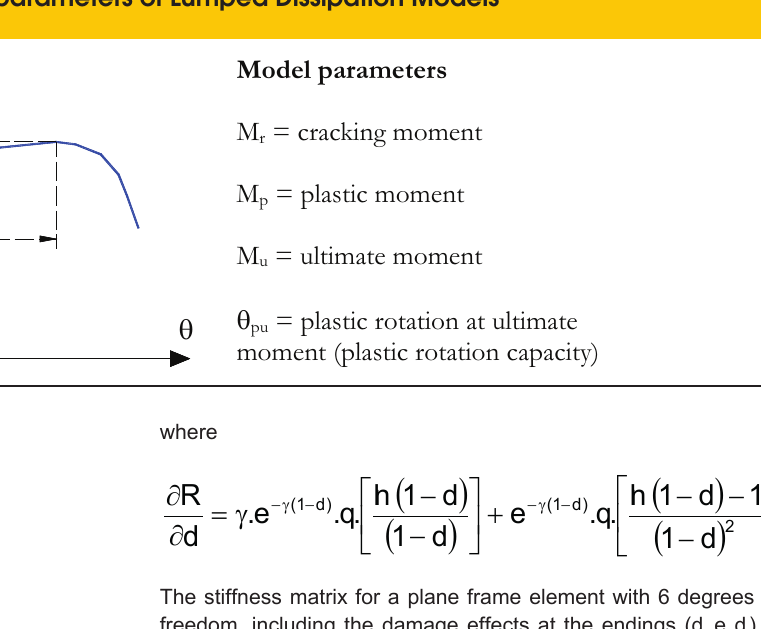
Figure 10 – Main parameters of Lumped Dissipation